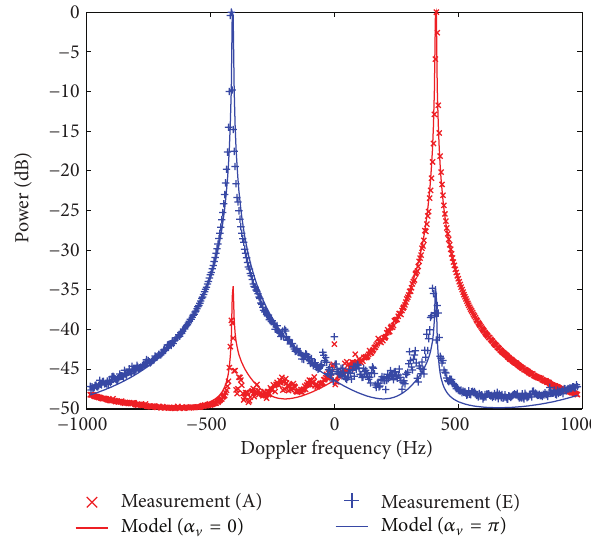
Figure 8: Doppler PSDs of the measurement and the proposed model for the obstructed environment (𝛿 𝑇 = 𝛿 𝑅 = 0) .